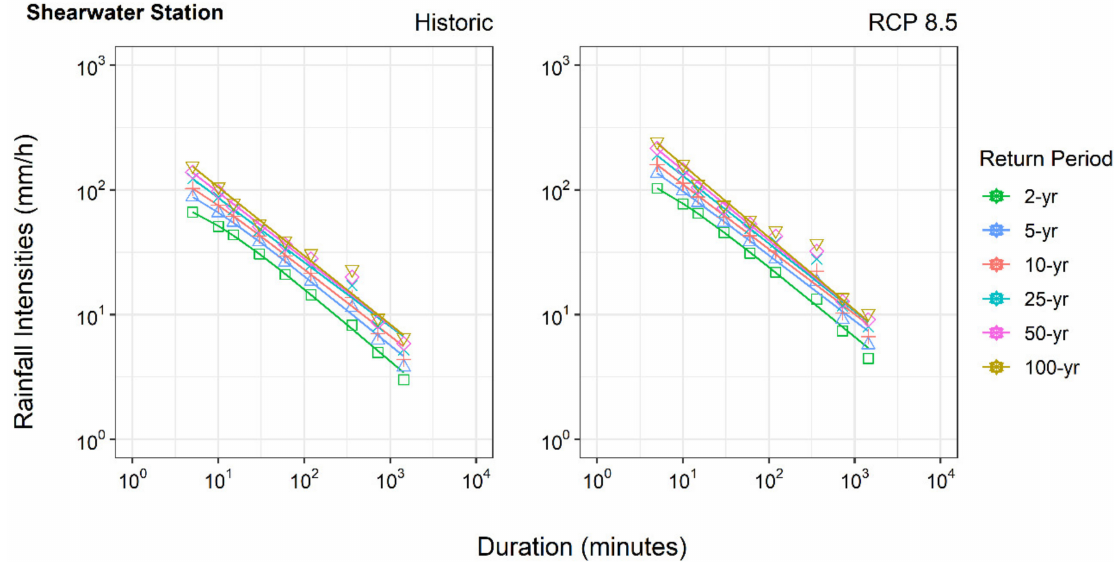
Figure 9. Rainfall intensities, in mm/h, estimated for the multimodel ensemble for the Shearwater station. X-axis is duration of precipitation in minutes, and Y-axis is the intensity of precipitation in